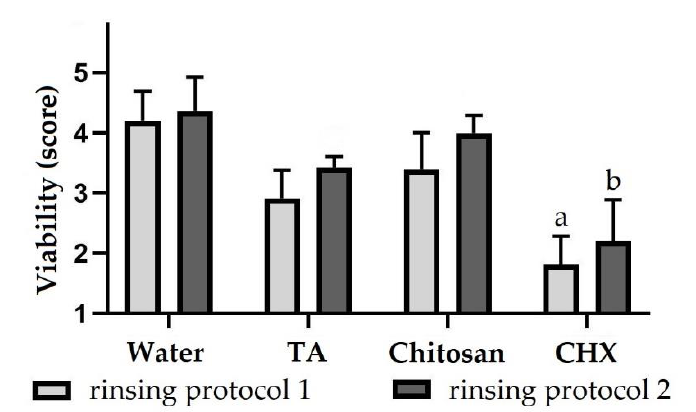
Figure 2. Bacterial viability (score 1–5) of biofilms formed on dentin specimens after rinsing with different rinsing solutions. Subjects carried intraoral splints with specimens for 48 h and rinsed with different experimental solutions. In rinsing protocol 1, rinsing was performed after 3 min, 12 h, 24 h, 36 h and 47.5 h and in rinsing protocol 2 after 3 min, 12 h, 24 h and 36 h. The biofilm formed on specimens was stained with LIVE/DEAD ® Baclight™ and evaluated using a scoring system. The height of the bars corresponds to mean values and the line applied to standard deviations. Friedman test followed by Dunn’s multiple comparison test: significant differences ( p < 0.05) to water are marked with a for rinsing protocol 1 and with b for rinsing protocol 2. TA = tannic acid, CHX = chlorhexidine.